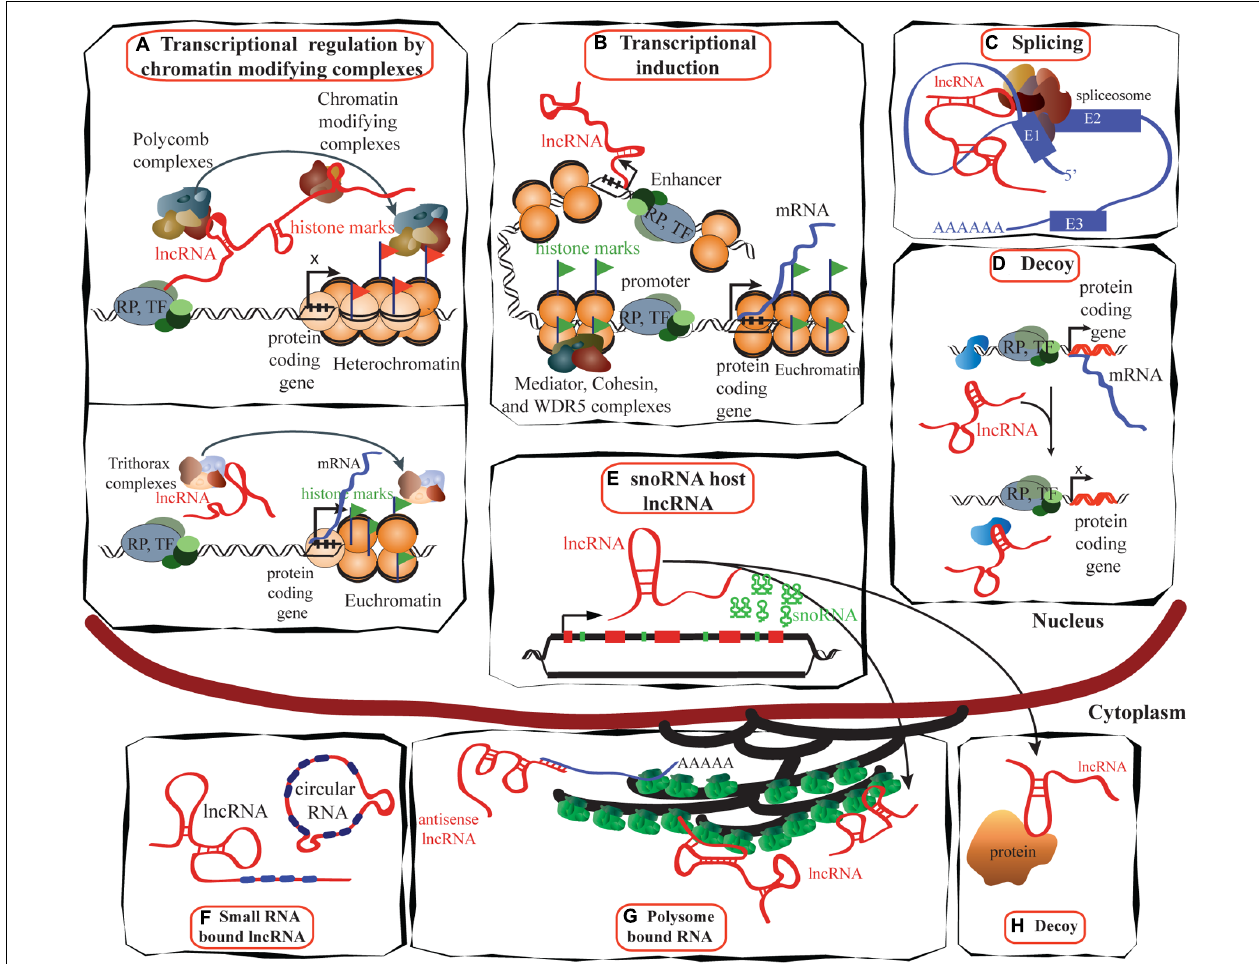
modifiers. This leads to broad changes in transcriptomes. (E) Intronic regions of many lncRNAs host snoRNAs. The snoRNAs derived from these lncRNAs remain in the nucleus while the spliced transcript can move to the cytoplasm and bind either to polysomes or to other proteins (Smith and Steitz, 1998). (F) LncRNAs can bind to miRNAs to sequester them and inactivate their repressive functions (reviewed in Gibb etal., 2011). (G) Many lncRNAs are associated with polysomes (van Heesch etal., 2014), while the mechanisms of many are yet to be identified, antisense lncRNAs such as UCHL1AS regulate the translation of associated mRNAs. (H) Decoy lncRNAs such as GAS5 are present in both in the cytoplasm and the nucleus: GAS5 translocates from the cytoplasm into the nucleus with glucocorticoid receptor in response